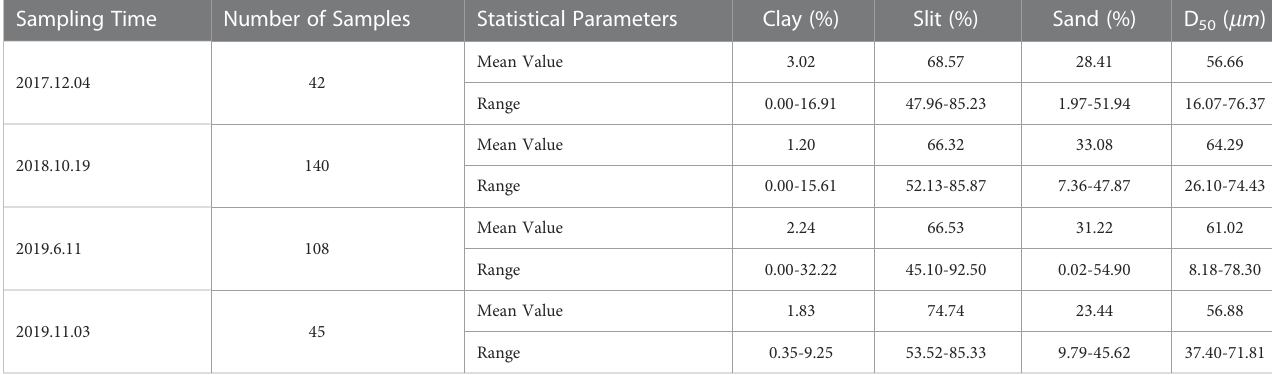
Sampling Time Number of Samples Statistical